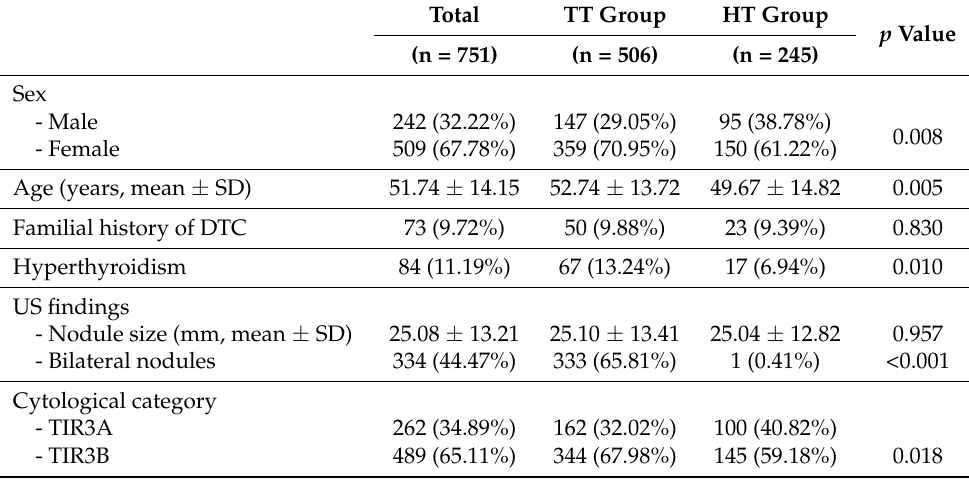
Table 1. Demographic and preoperative data regarding the whole sample, TT Group and HT Group.